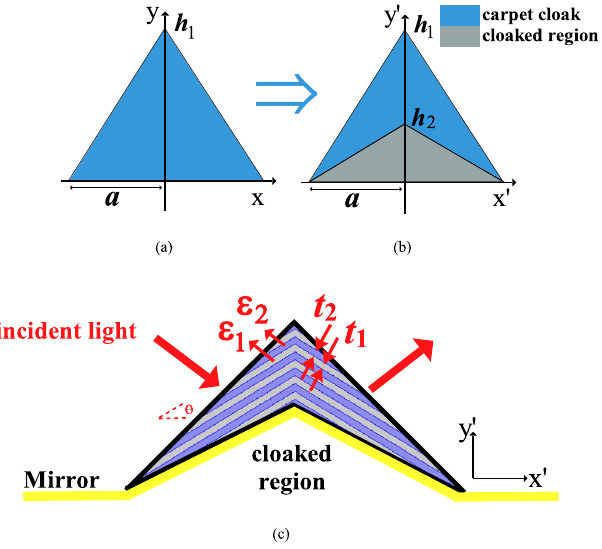
Figure 1. Scheme of the coordinate transformation ( a ) virtual space, ( b ) physical space. The cloaked region is shown in gray. ( c ) The schematic of a carpet cloak realized by alternating dielectric 1 and 2 . Any object in the cloaked region is invisible to incident